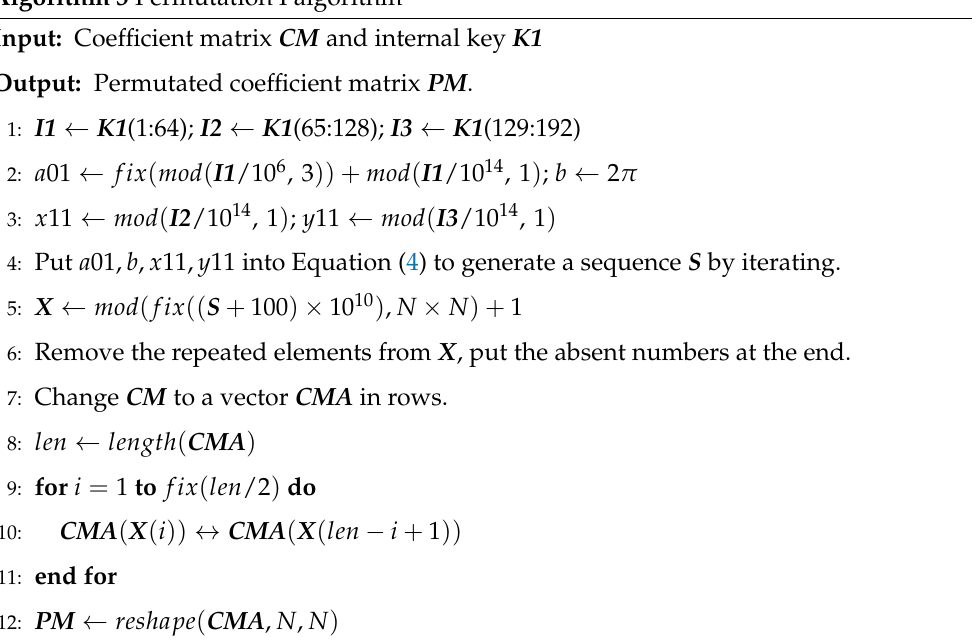
Algorithm 3 Permutation I algorithm